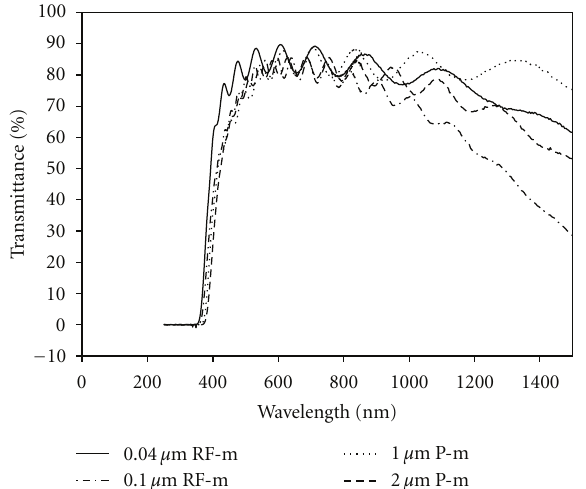
Figure 10: Transmittance for the ZnO:Al 2 O 3 films of four di ff erent thicknesses grown by two di ff erent techniques.